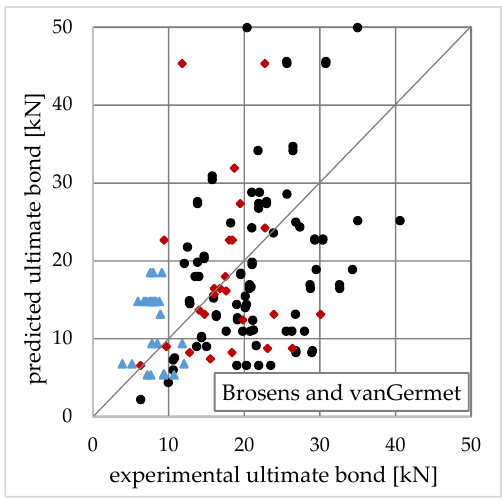
Figure 11. Test vs. predicted bond force using the Brosens van Germet model [23]. Appl. Sci. 2020 , 10 , 8593